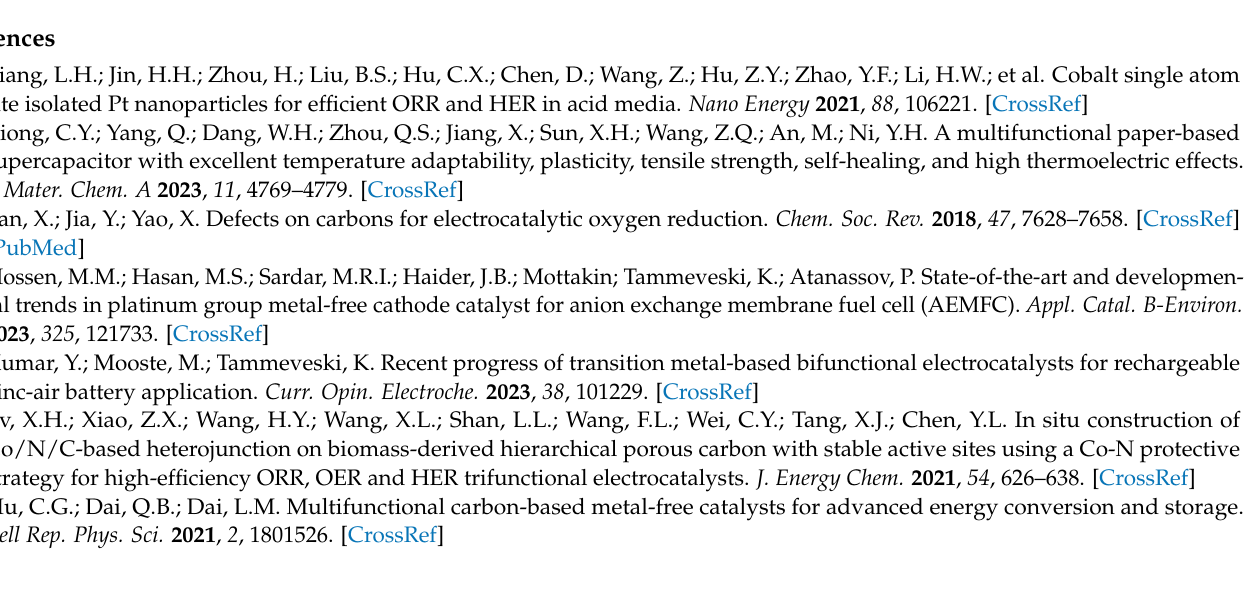
Figure S7: Pore size distribution curves of CoSA/N − PCMS and Co/N − PCMS, Figure S8: XPS full scan of CoSA/N − PCMS, Figure S9: Co K-edge EXAFS fitting analysis of CoSA/N − PCMS in R space, Figure S10: (a) TEM image of FeSA − N PCMS. (b) HAADF-STEM image of FeSA − N PCMS with partially atomically dispersed Fe atoms circled. Figure S11: (a) LSV curves at different rotating rates of CoSA/N − PCMS. (b) the Koutecky-Levich plots, Figure S12: XRD patterns of CoSA/N − PCMS before and after ADT testing, Figure S13: Chronoamperometry (i-t) measurement of CoSA/N − PCMS and Pt/C with a rotation rate of 1600 rpm in O 2 -saturated 0.1 M KOH, Figure S14: (a) CV curves of CoSA/N − PCMS, Co/N − PCMS, N − PCMS and Pt/C in O 2 -saturated 0.1 M HClO 4 with a sweep rate of 10 mV s − 1 . (b) LSV curves of CoSA/N − PCMS, Co/N − PCMS, N − PCMS and Pt/C in O 2 -saturated 0.1 M HClO 4 with a sweep rate of 10 mV s − 1 and 1600 rpm, Figure S15: Chronoamperometry (i-t) measurement of CoSA/N − PCMS and Pt/C with a rotation rate of 1600 rpm in O 2 -saturated 0.1 M HClO 4 ; Table S1: eZAF Smart Quant Results of CoSA/N − PCMS, Table S2: EXAFS fitting parameters at the Co K-edge (S 02 =0.76), Table S3: Summary of ORR activity of different catalysts in this work under alkaline condition, Table S4: CoSA/N − PCMS compared with recently reported Co SACs. References [34,62–66] are cited in Supplementary